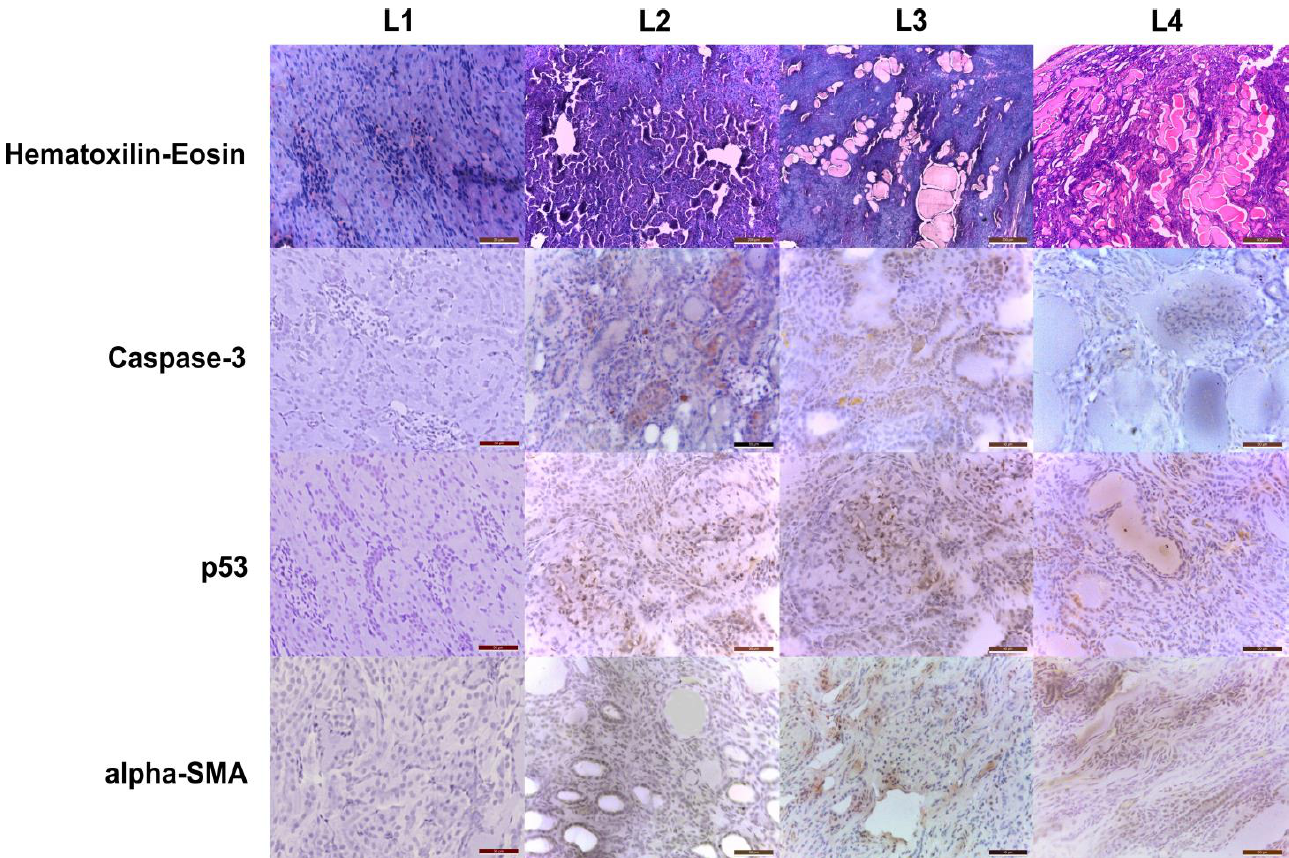
Figure 4. Renal histopathology slides point to progressive toxicity across groups, with increasing areas of glomerular sclerosis and tubular atrophy paralleled by an increased density of expression for genotoxic, apoptosis, and fibrosis markers (left panels, scale bar = 20-50-50-50 μm, middle panels, scale bar = 200-50-50- 50 μm and 500 -50-50-50 μm and right panels, scale bar = 500-50-50-50 μm; 10-20-100X magnification).